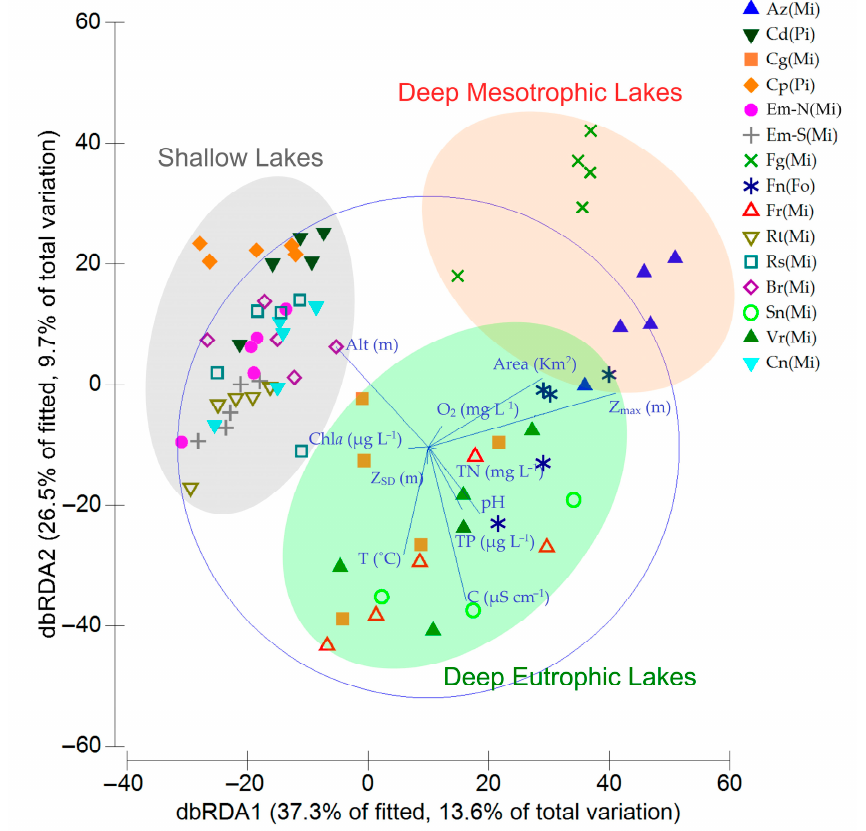
Figure 3. Distance-based redundancy analysis (dbRDA) plot of Distance-based linear modeling (DistLM) results in 2-dimensional space for environmental variables and cyanobacteria biomass across the studied lakes. The length and direction of the vectors represent the strength and direction of the relationship (see Table 1 for environmental variables and lake